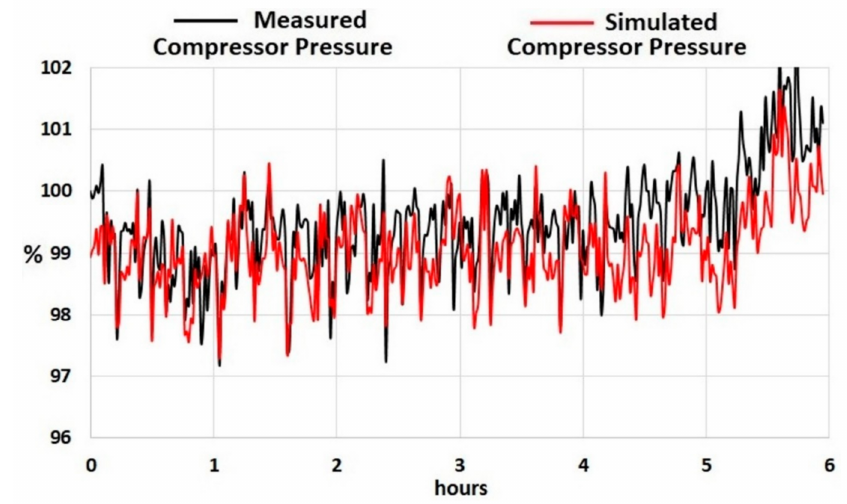
Figure 38. Measured and simulated compressor discharge pressures at high IGV offset.